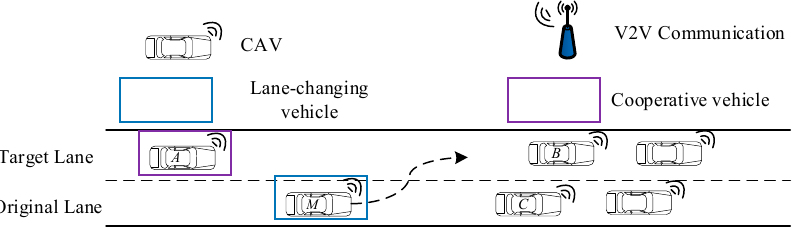
Figure 1. The CLC scenario on a two-lane highway.